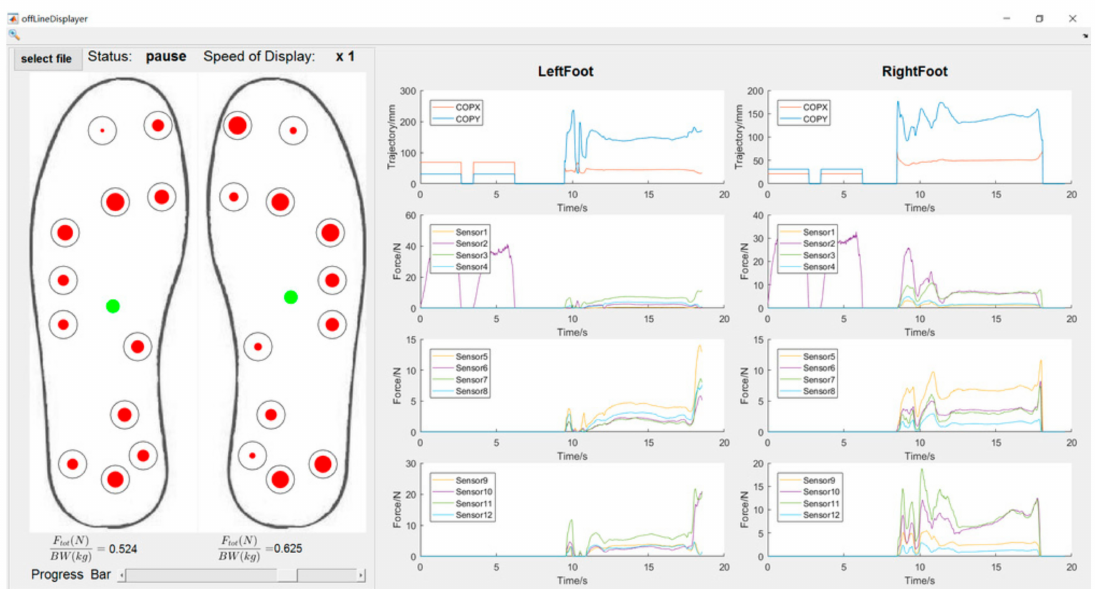
Figure 5. The GUI developed in the MATLAB to show the output of each sensor, F tot normalized by body weight (BW), and the estimated foot plantar COP